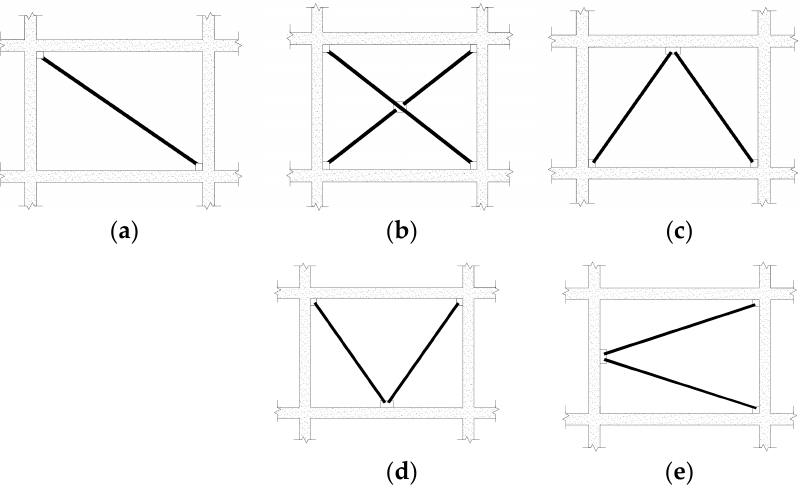
Figure 1. Concentrically Braced Frames: ( a ) single diagonal bracing, ( b ) cross bracing, ( c ) Λ bracing (chevron), ( d ) V bracing (chevron), ( e ) K bracing.